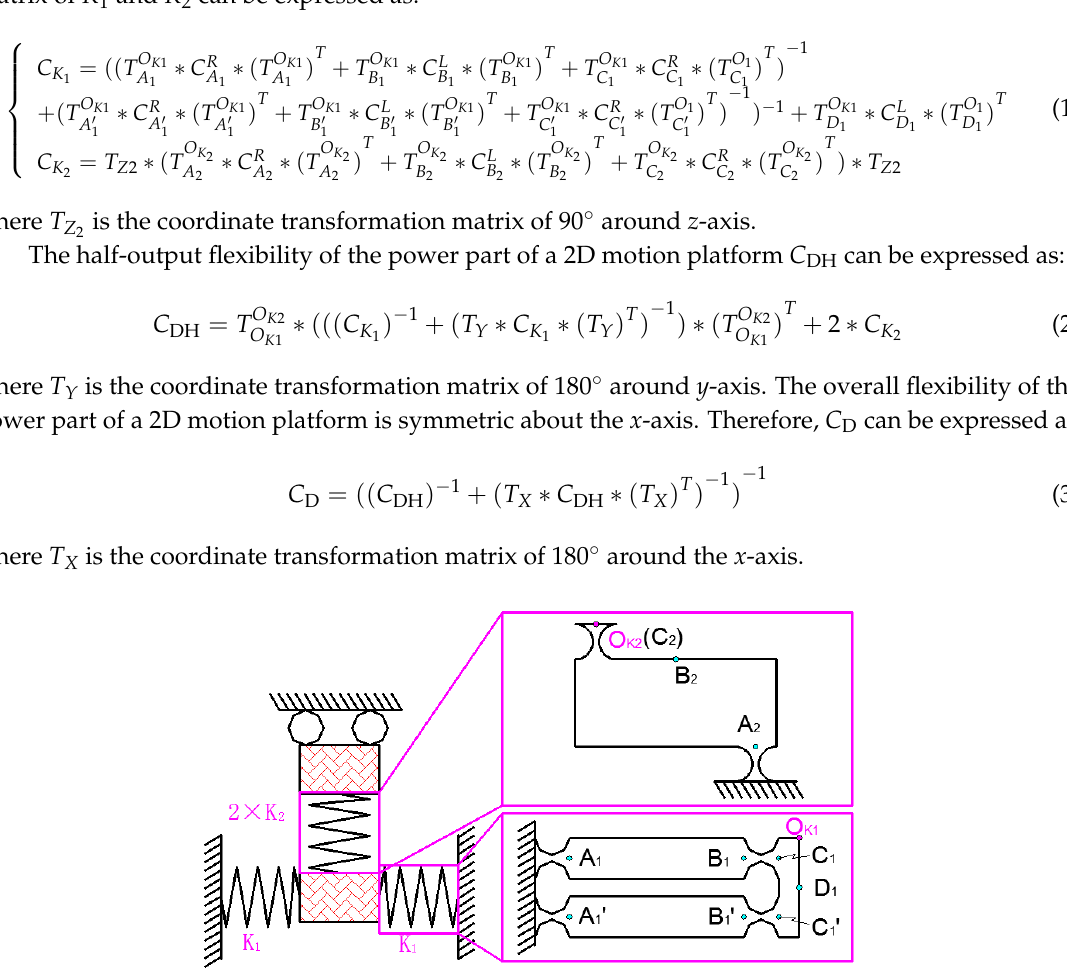
Figure 10. Static analysis of x and y power part.